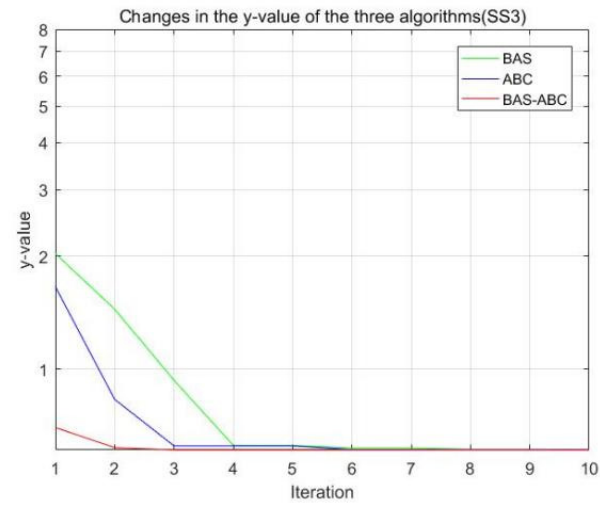
Figure 9. Changes in the 𝑦 value of the three algorithms (SS3).